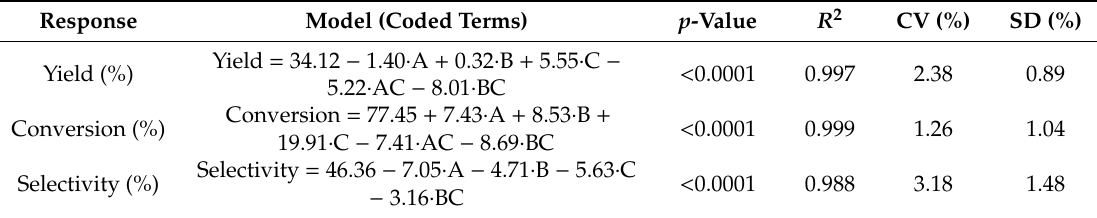
Table 2. Models in coded terms obtained for yield, conversion, and selectivity in a factorial design. A = concentration of FeCl 3 , B = time, and C = temperature. CV, coe ffi cient of